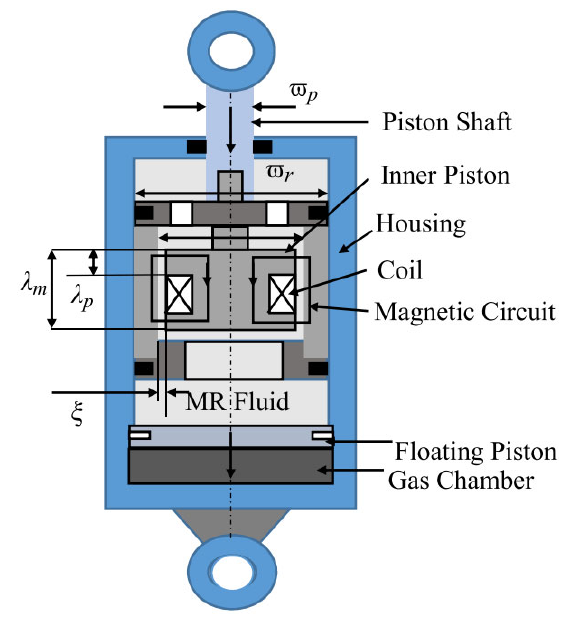
Figure 8. Schematic configuration of the MR damper